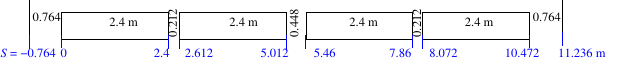
FIG. 3. A sketch of RHIC snake and rotator layouts, each rectangle represents a 2.4 m long 360°-twist helix. Field maps from the OPERA model extend an extra 0.764 m at both ends, to encompass field falloffs.